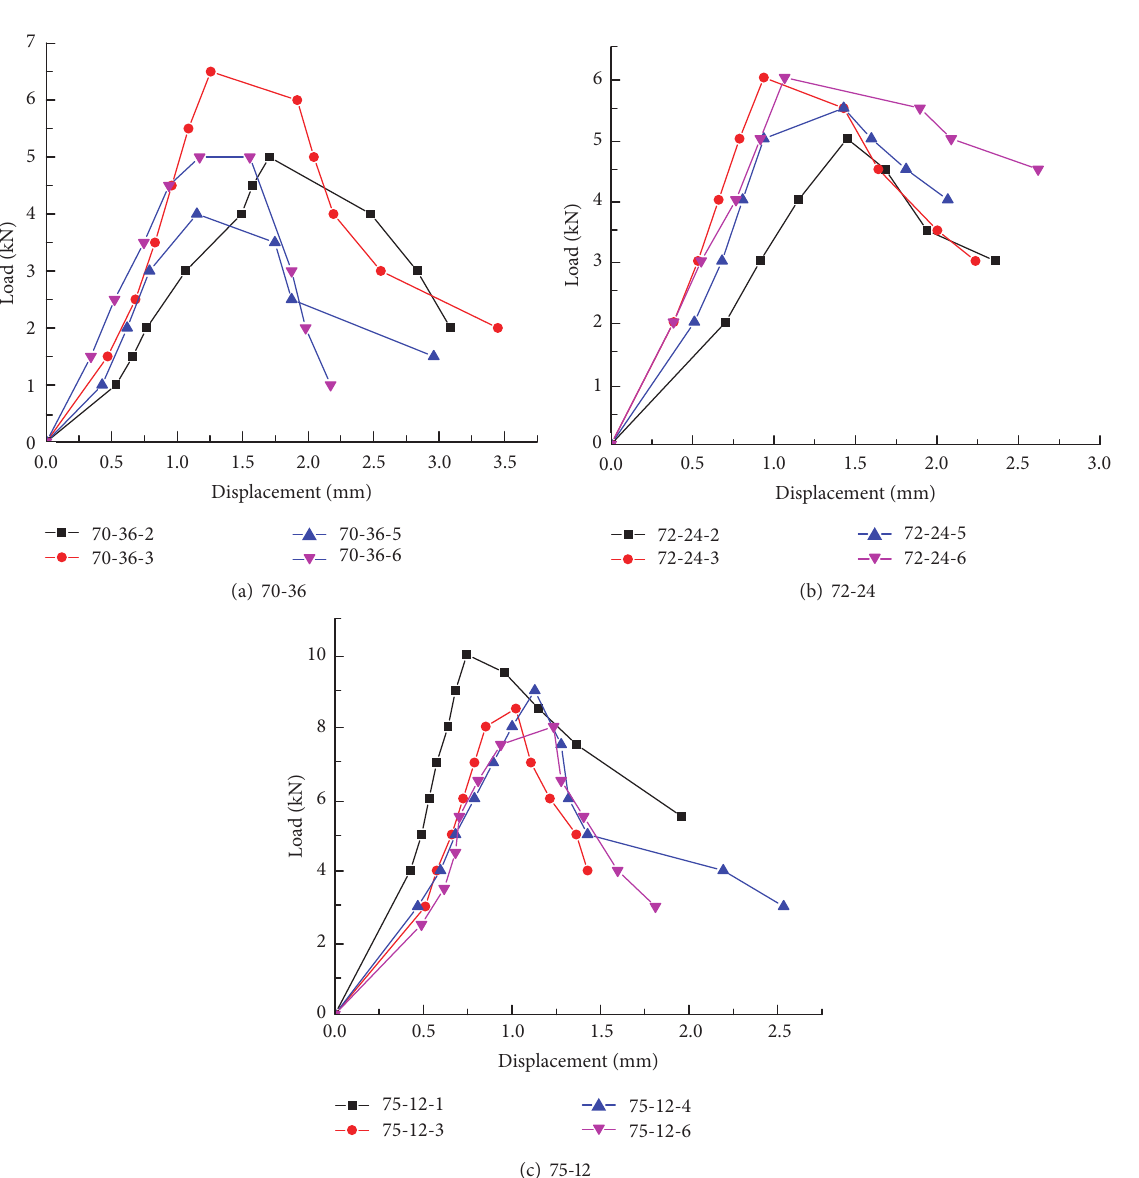
Figure 7: The relationship between loading and displacement under different